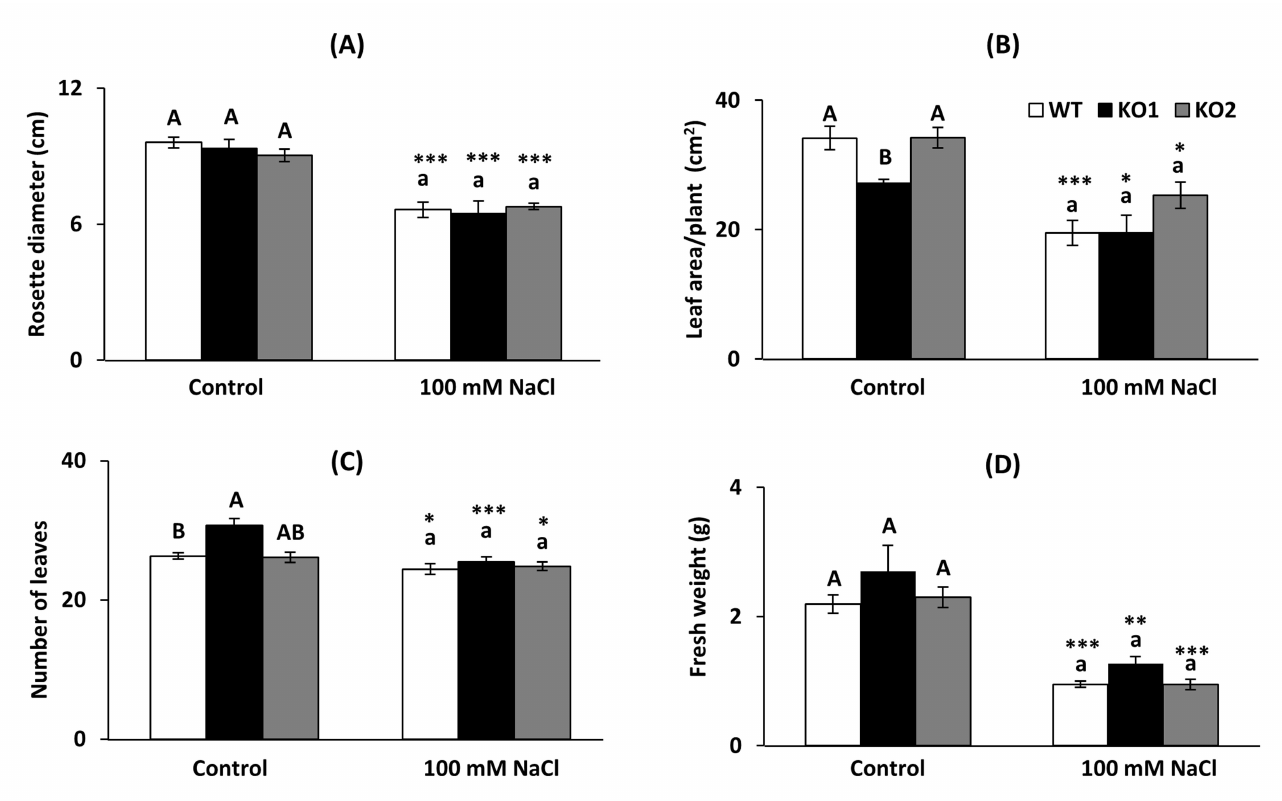
Figure 1. Phenotypic characterization of growth parameters. ( A ) Rosette diameter, ( B ) total leaf area, ( C ) number of leaves and ( D ) fresh weight of the aerial part of A. thaliana plants. Wild type plants (WT) and two Attrxo1 mutant lines (KO1 and KO2) were grown in the absence (Control) and presence of 100 mM NaCl. Data are the mean ± SE of at least eight independent experiments. Different letters indicate significant differences ( p < 0.05) among genotypes in each condition according to the Tukey’s test, and the asterisks indicate significant differences of each genotype in salinity compared to the control condition using the t -Student’s test (*, **, *** at p < 0.05, p < 0.01 and p < 0.001,